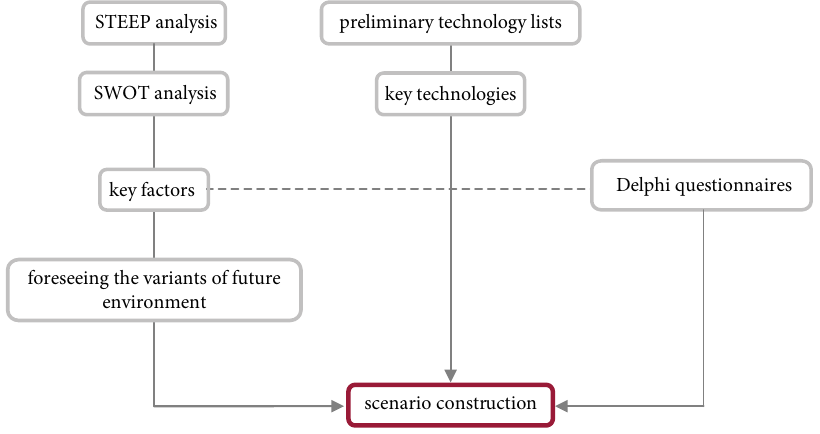
Fig. 1. Scenario building process in PM, SLV and FEI